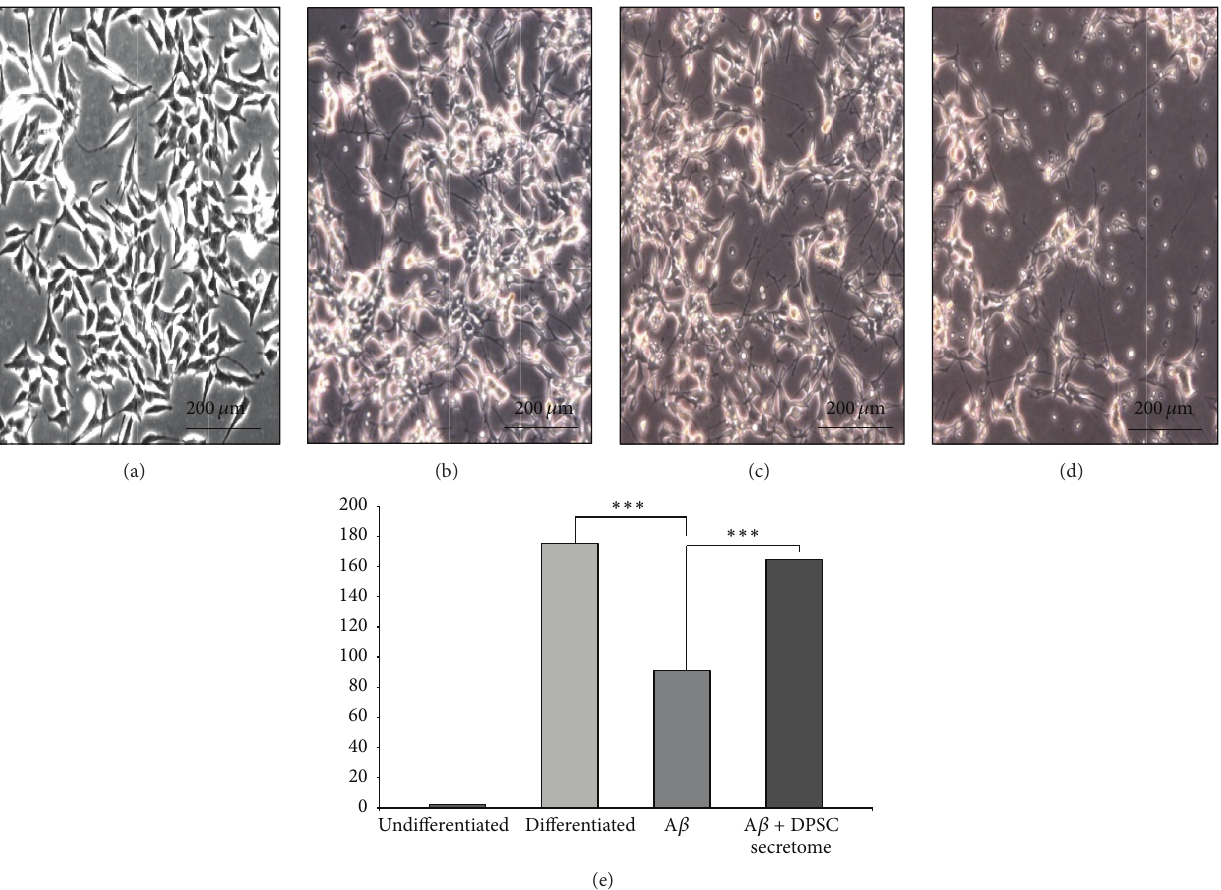
Figure 7: DPSC secretome has neuroprotective ability against A 𝛽 1 morphology of SH-SY5Y cells in different treatment groups: undifferentiated, nonexposed differentiated, differentiated exposed to A 𝛽 1 and DPSC secretome, and differentiated exposed to A 𝛽 1 analysis of SH-SY5Y neurite outgrowth after exposure to A 𝛽 1